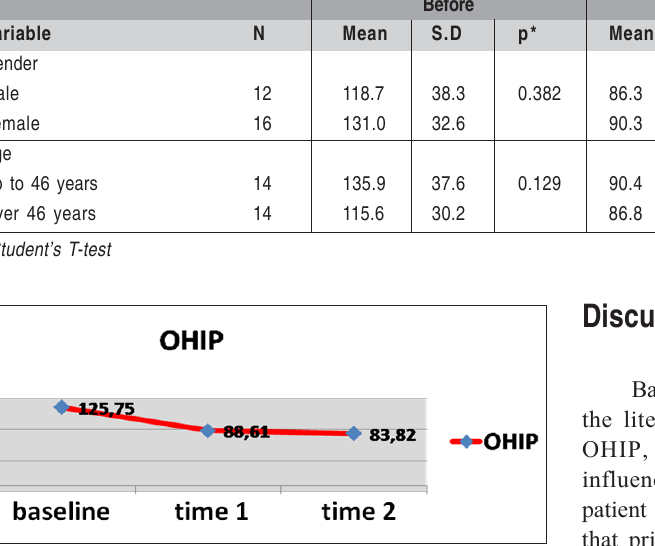
Fig. 1. Mean OHIP value in relation to time: before (baseline), after 3 months (time 1) and after 2 years (time 2) of removable partial denture